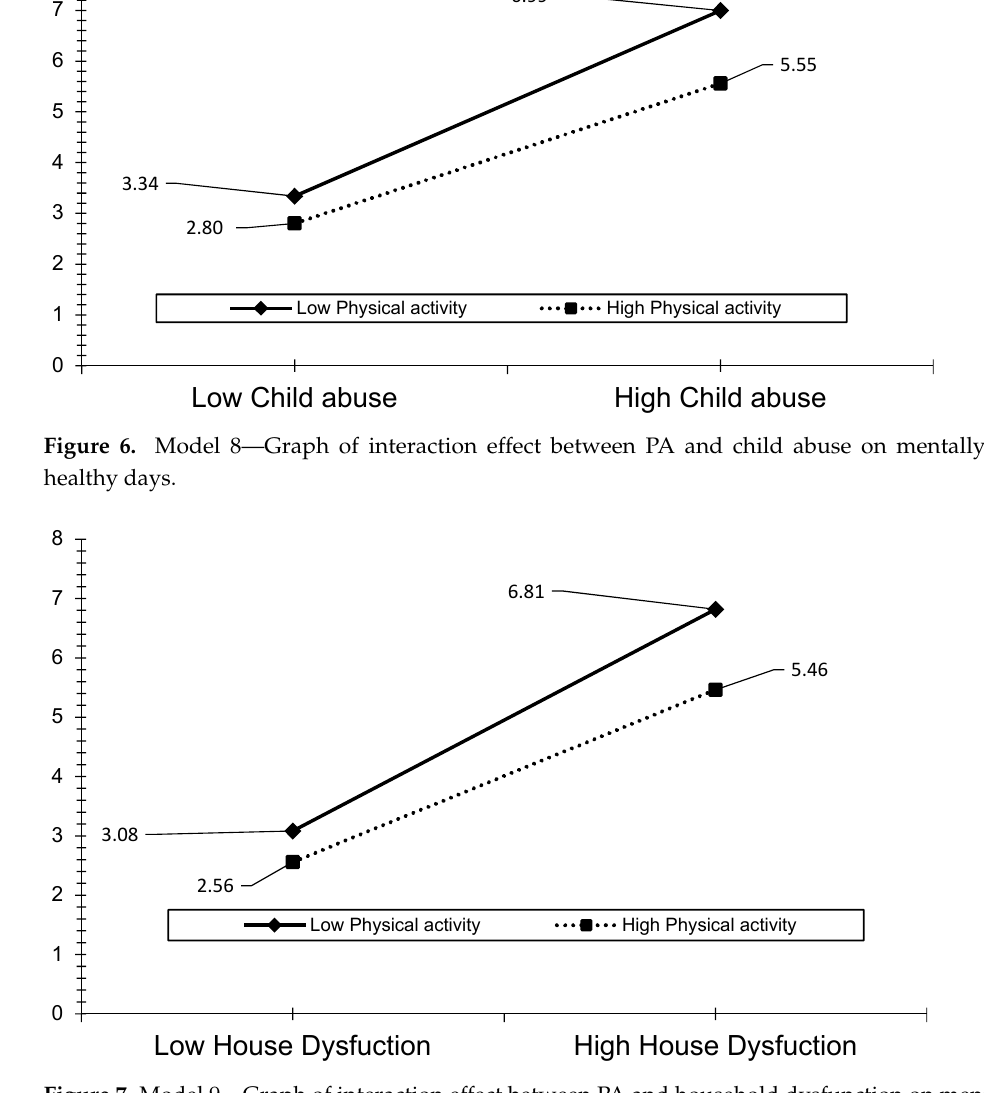
Figure 7. Model 9—Graph of interaction effect between PA and household dysfunction on mentally unhealthy days.